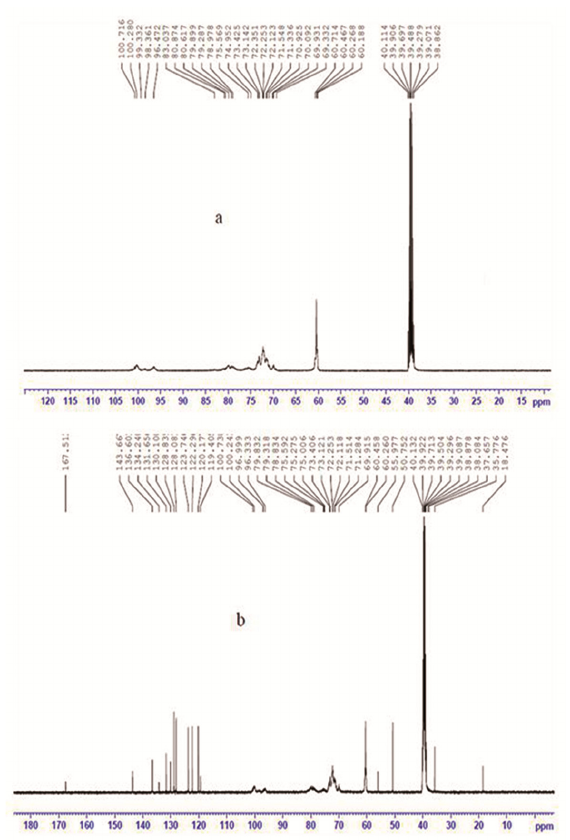
Figure 2. 13 C-NMR spectra of xylan (spectrum ( a )) and CAX (spectrum ( b ), sample 17 in Table 1).